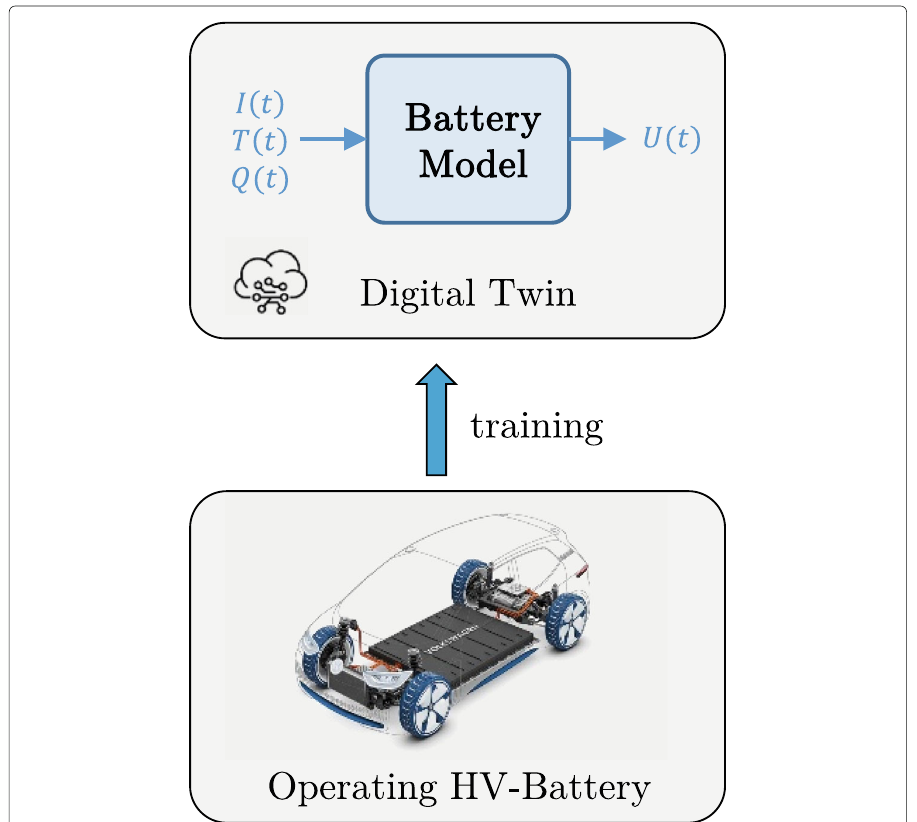
Fig. 1 Concept of system identification approach. A digital battery model learns the electro-thermal behavior based on operational in-vehicle data